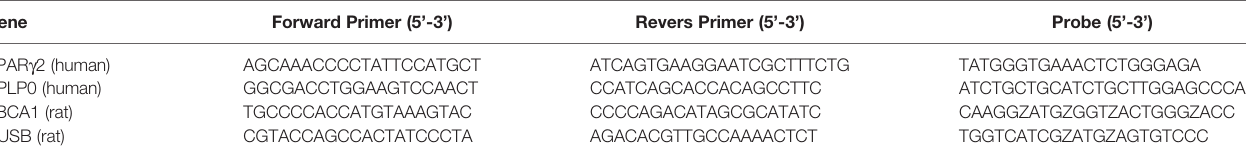
TABLE 1 | DNA sequence of primers and probes for RT-qPCR of HT-29 cells and for neoplastic tissue from rat.